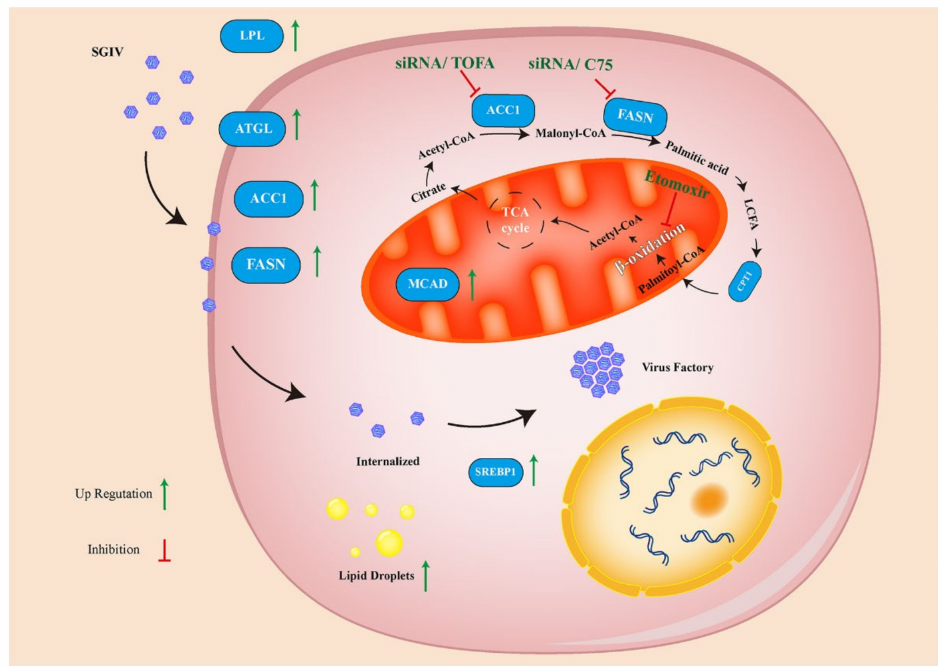
Figure 9. Model for the roles of de novo fatty acid biosynthesis during SGIV infection. The de novo fatty acid biosynthetic pathway was utilized through SGIV infection. Inhibition of ACC1 (converts acetyl-CoA to malonyl-CoA), FASN (catalysis malonyl CoA with acetyl-CoA to generate palmitate) and fatty acid β -oxidation significantly decreased SGIV replication. Key FAs synthesis enzymes and processes are shown in blue. Inhibitors and siRNA are shown in dark